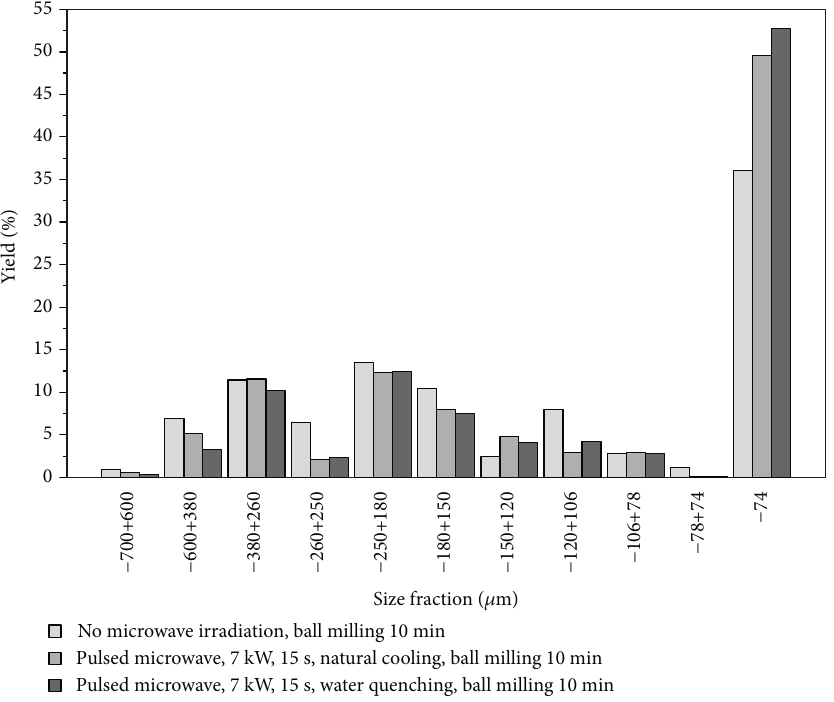
Figure 9: E ff ect of cooling method on size fraction distribution of grinding products after pulsed microwave pretreatment.